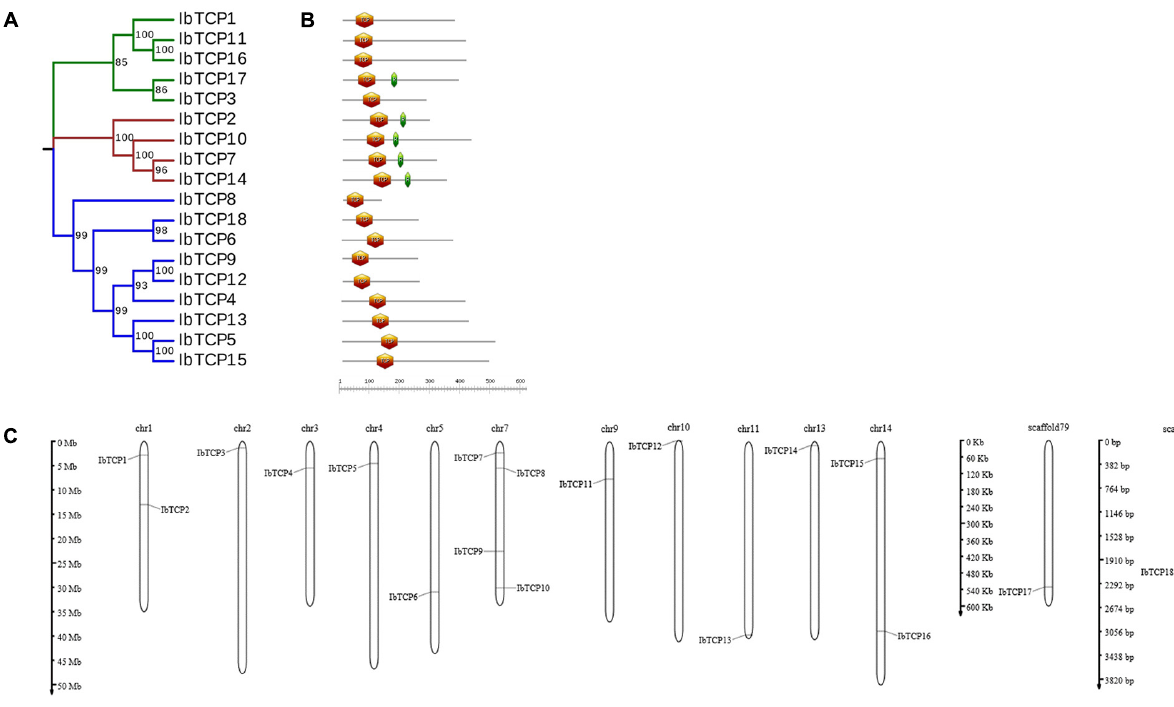
FIGURE 1 | Distribution, phylogenetic tree, and conserved motifs analysis of IbTCPs in sweet potato. (A) Phylogenetic tree of 18 IbTCP genes. The phylogenetic tree was generated using the neighbor-joining method with 1000 bootstrap iterations. Numbers at each node represent the bootstrap values. The blue, green, and red colors indicate the PCF, CIN, and CYC/TB1 clades. (B) Conserved motifs analysis. Orange hexagon indicated the TCP domain, and green prism indicated the R domain. The scale refers to the amino acid residues lengths of the TCP proteins. (C) Distribution of IbTCPs on sweet potato chromosomes or scaffolds. The scale refers to the lengths of the chromosomes or scaffolds in hexaploid sweet